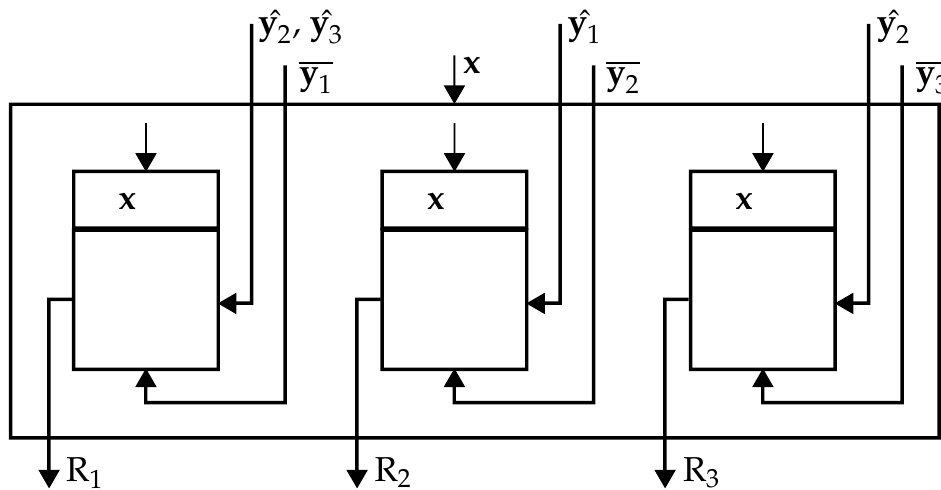
Figure 10. Flowchart of the all-at-once architecture: details of the analysis block from Figure